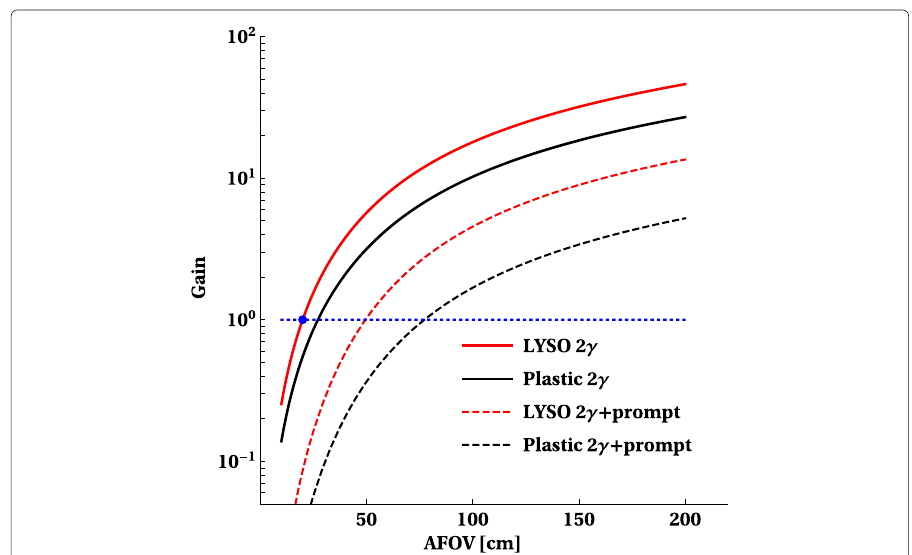
Fig. 3 Relative gain in sensitivity S as a function of the AFOV of the scanner. The gain is calculated relative to sensitivity for the standard 2 γ imaging using LYSO PET with AFOV = 20 cm (blue dot). The gains for 2 γ (solid lines) as well as for 2 γ + γ prompt (dashed lines) are shown for LYSO and plastic scintillators as indicated in the legend. The red and black color indicate result for the LYSO and plastic scintillators, respectively